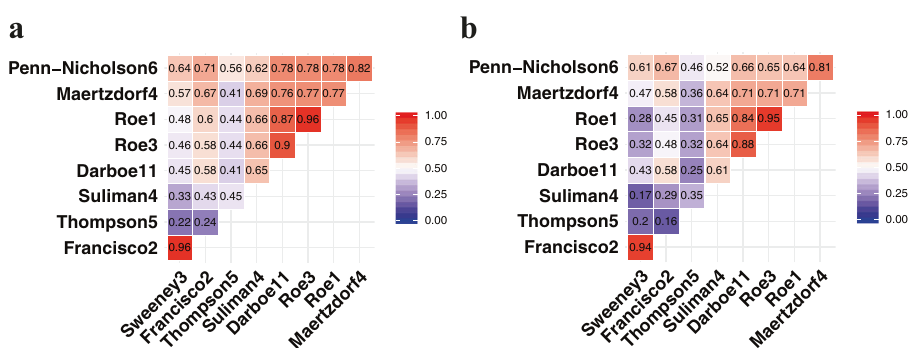
Fig. 1 Correlation between parsimonious signature scores. Signature score correlation matrix with the Spearman-rank-order correlation coef fi cients in ( a ) the CORTIS-01 study of people without HIV ( n = 2045 # ) and ( b ) the CORTIS-HR study of people living with HIV ( n = 546 # ). Roe1 and Roe3 signatures were multiplied by − 1 to obtain a positive correlation for all signatures. # Only participants with signature scores available for all signatures were included in the Spearman correlation analysis.